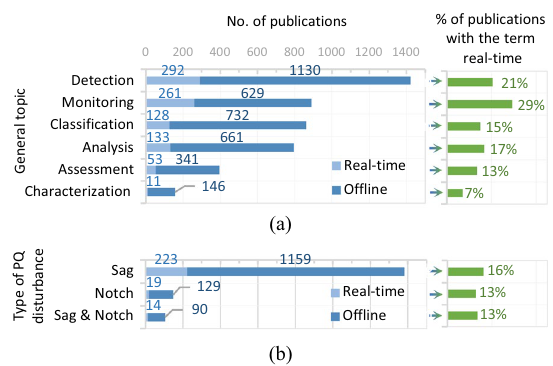
Fig. 6 Number of publications by a topic and b type of PQD, with or without the term “real‑time”, and respective